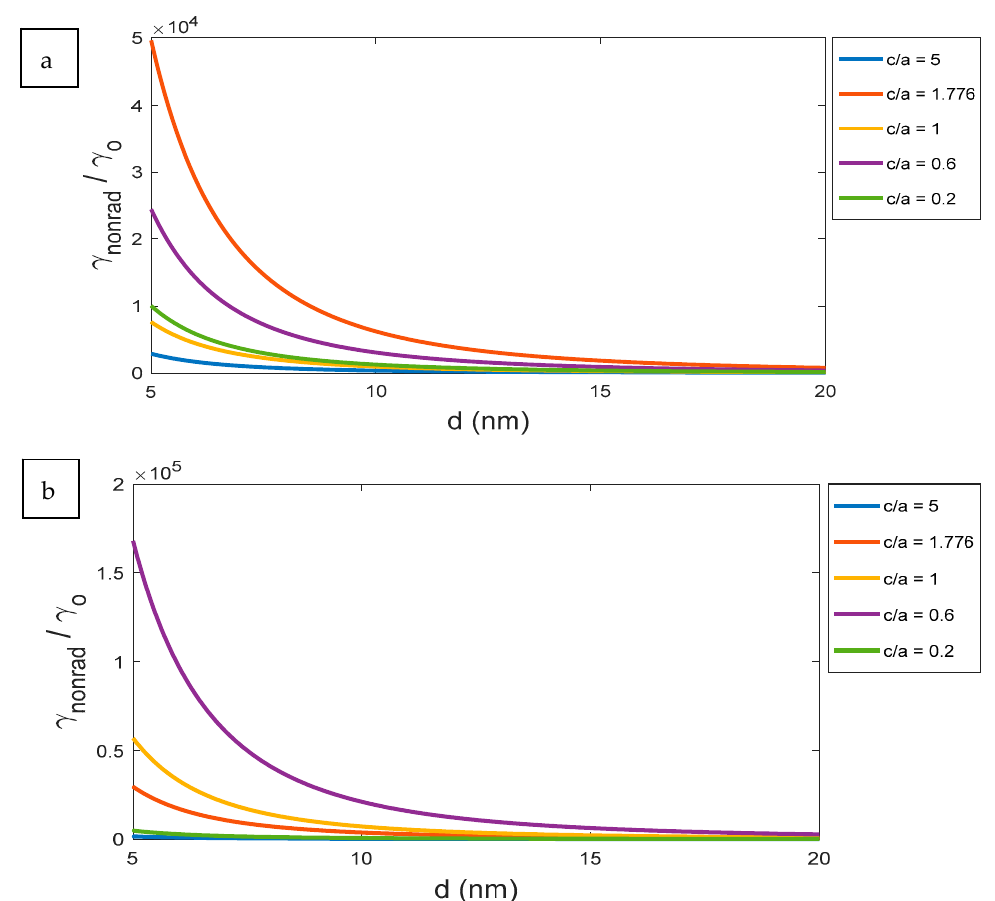
Figure 10. The effect on non-radiative decay rate γ nonrad with change the distance d of the excited atom from the surface at a certain wavelength: ( a ) 550 nm and ( b ) 800 nm.